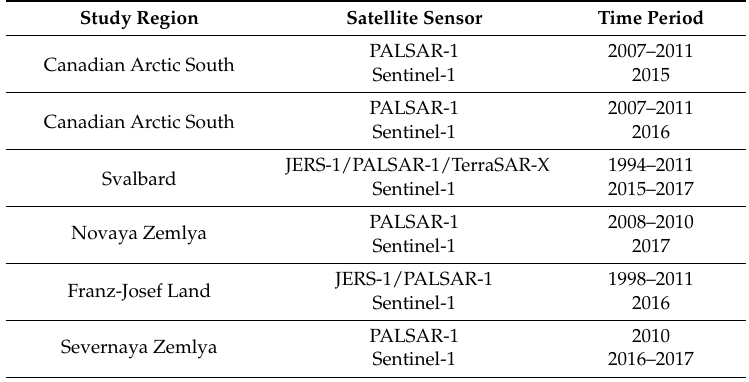
Table 1. Overview of sensors and time periods for the ice velocity maps of Figures 2 and 3 for the different study